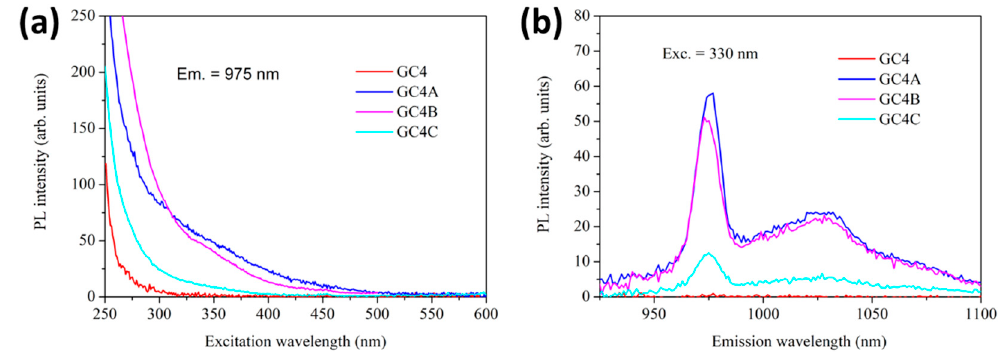
Figure 4. PL excitation ( a ) and near-infrared (NIR) emission ( b ) of Yb-doped samples before Ag-exchange (GC4), after exchange (GC4A), and after annealing at 380 °C (GC4B) and 430 °C (GC4C). A broadband excitation up to about 500 nm can be observed after Ag-exchange. Moreover, 330 nm wavelength is not absorbed by Yb 3+ ions, while it provides a strong PL emission in Ag-exchanged samples.